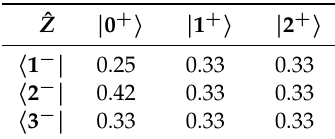
Table 2. Transition dipole matrix elements (cid:104) i − | ˆ Z | j + (cid:105)